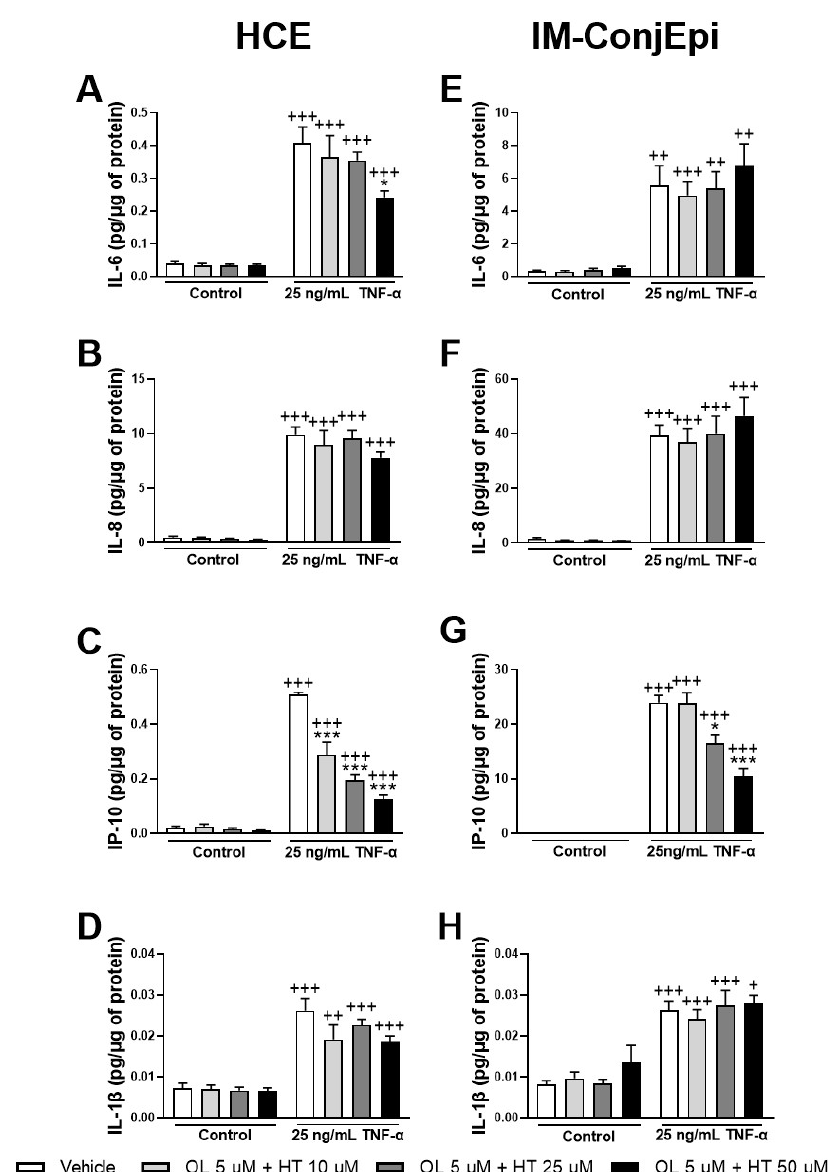
Figure 7. Effect of the mixture of Hydroxytyrosol (HT) and Oleuropein (OL) on TNF- α -induced cytokine release by HCE ( A – D ) and IM-ConjEpi ( E – H ) cells. Cells were pre-treated with 5 μ M of OL + 10 μ M of HT, 5 μ M of OL + 25 μ M of HT, 5 μ M of OL + 50 μ M of HT, or vehicle (cell culture medium) for 2 h. Following this, they were stimulated with 25 ng/mL TNF- α in the presence of the treatments for 24 h. Vehicle-treated-TNF- α stimulated cells and cells not stimulated with TNF- α were used as control. IL-6, IL-8, IP-10, and IL-1 β were measured in cell supernatants by a multiplex bead-based array. For HCE cells, 5 μ M of OL + 10 μ M of HT had a synergistic effect, decreasing IP- 10 levels ( C ), whereas the decrease of IL-6 levels by 5 μ M of OL + 50 μ M of HT ( A ) can also be achieved by 50 μ M HT alone. None of the mixtures tested were able to decrease IL-8 ( B ) or IL-1 β ( D ) secretion significantly. For IM-ConjEpi cells, 5 μ M of OL + 25 μ M of HT reduce IP-10 production ( G ); however, this is also demonstrated by HT alone. None of the mixtures were able to inhibit IL-6